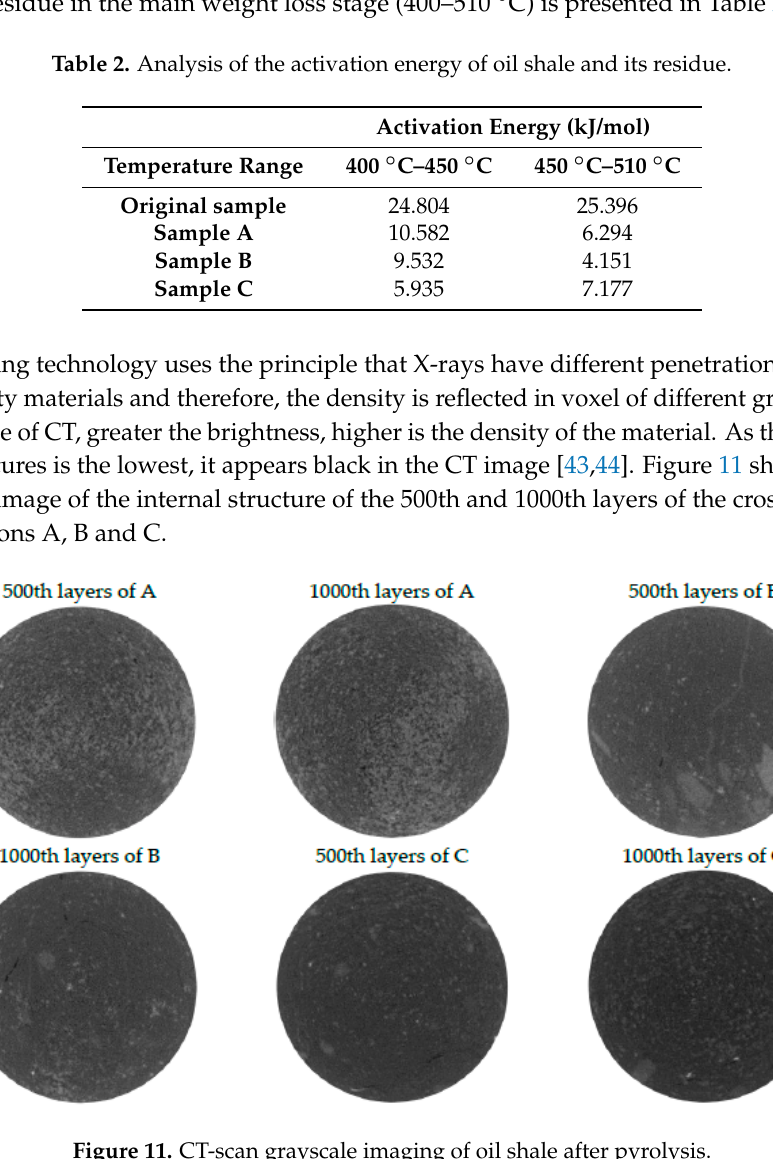
Figure 12. The workflow for processing images from CT scan. Figure 13. Oil shale CT-scan imaging after the binarization processing.